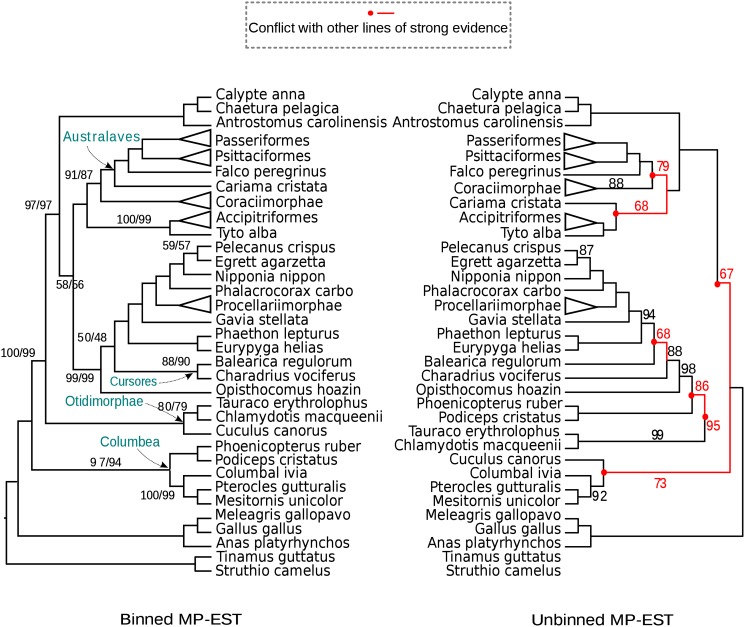
Trees computed on the avian biological dataset using MP-EST on MLBS gene trees.We show results with weighted and unweighted binning (left), and unbinned analyses (right). We used 50% bootstrap support threshold for binning. Supergene trees were estimated using fully partitioned analyses. MP-EST with weighted and unweighted binning returned the same tree. The branches on the binned MP-EST tree are labeled with two support values side by side: the first is for unweighted binning and the second is for weighted binning; branches without designation have 100% support. Branches in red indicate contradictions to known subgroups.